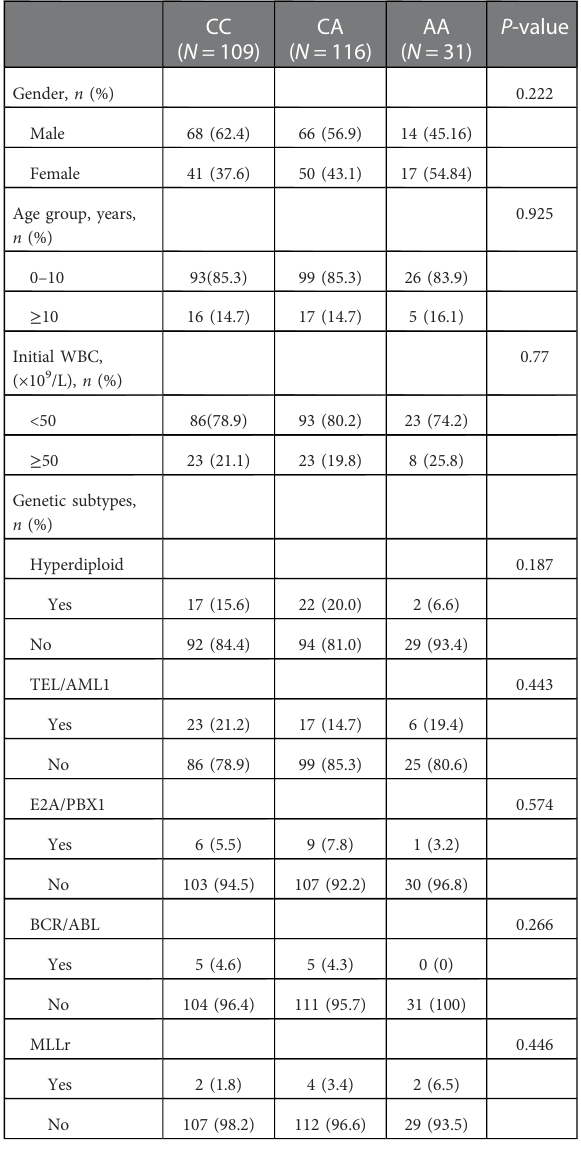
TABLE 2 The characteristics of ALL patients according to GATA3